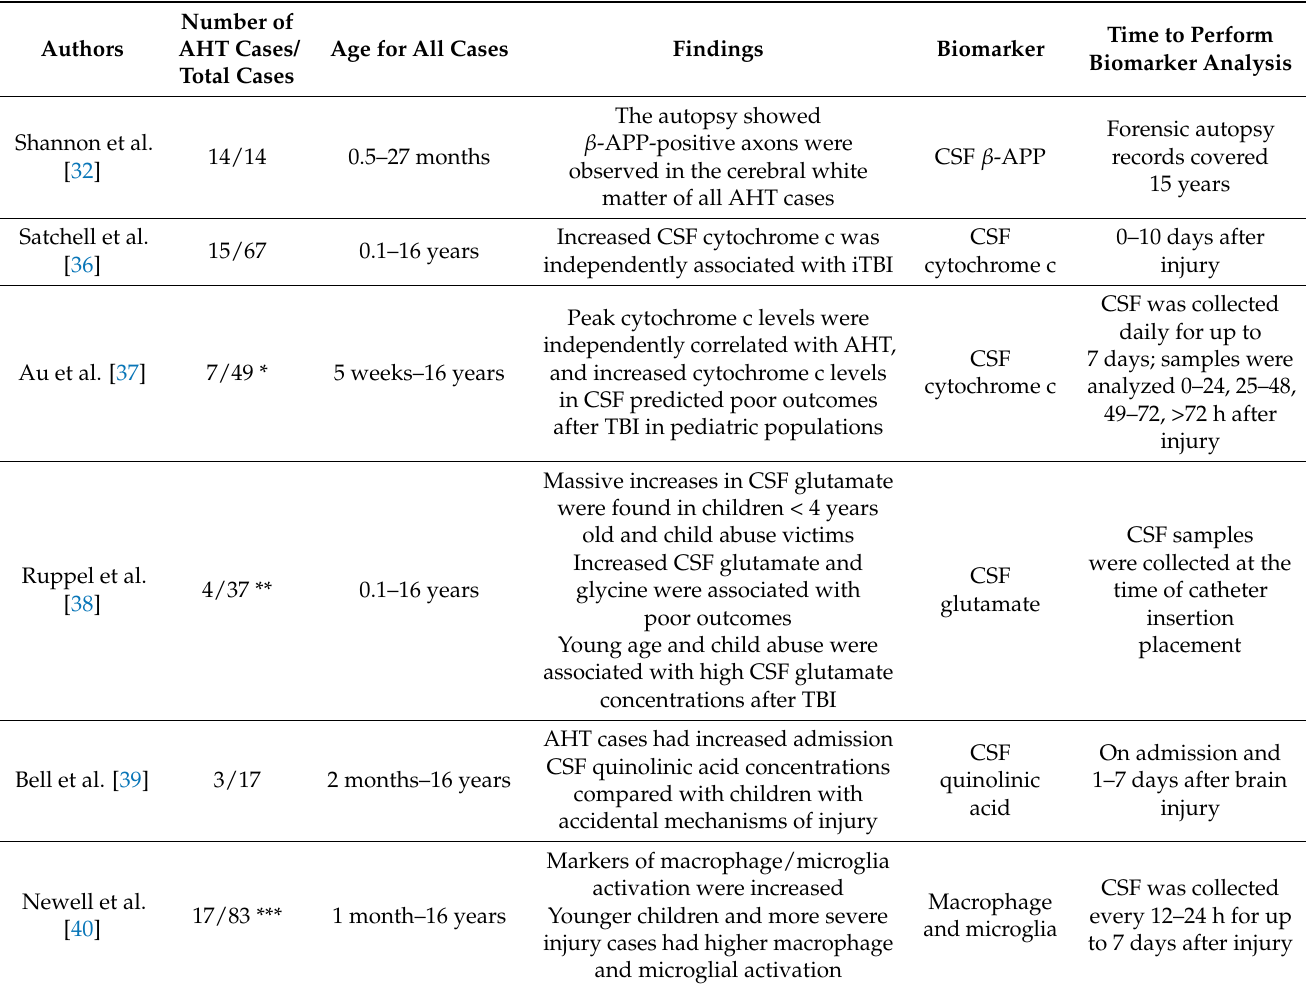
Table 1. Biomarkers and findings in clinical AHT